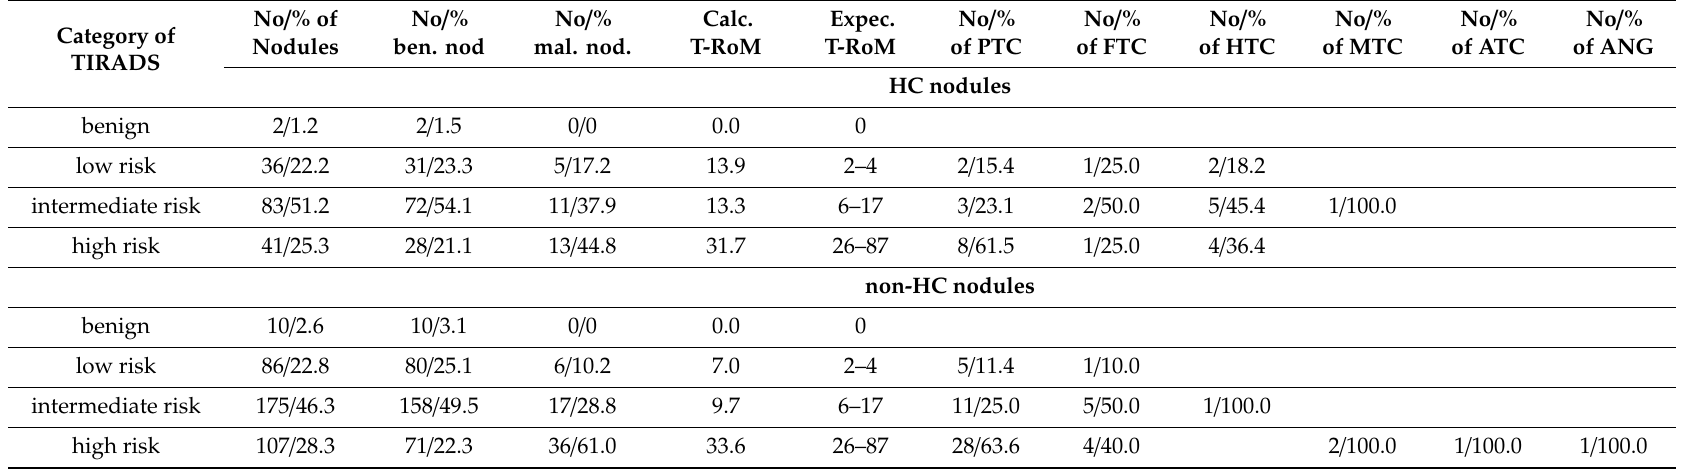
Table 3. Distribution of benign and malignant nodules (and their types) between particular categories of EU-TIRADS, the comparison of expected T-RoM with calculated T-RoM. (EU-TIRADS category corresponding to the lack of nodules has been omitted). No / % of No / % Category of Nodules ben. nod mal. TIRADS